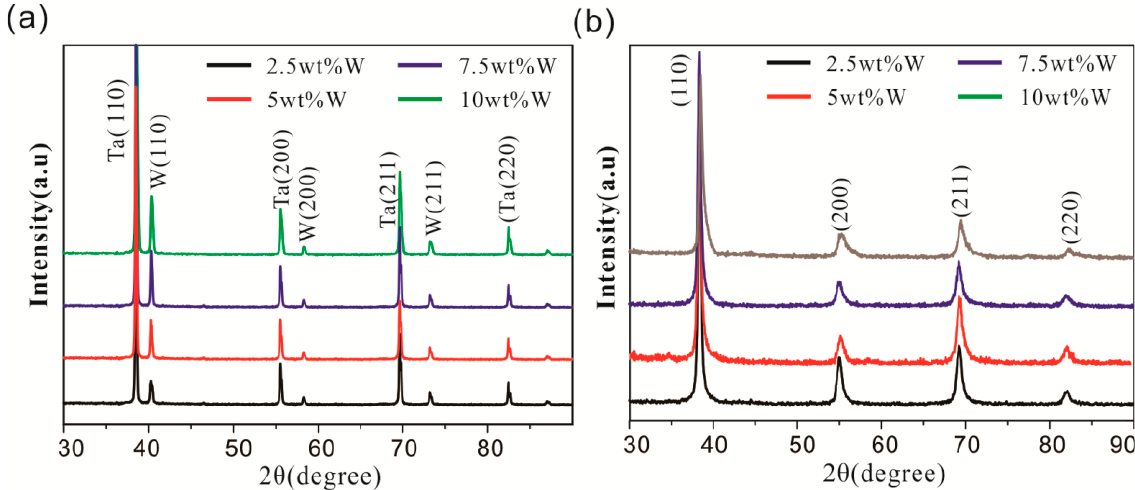
Figure 4. XRD patterns of powder mixtures ( a ), and sintering samples ( b ).